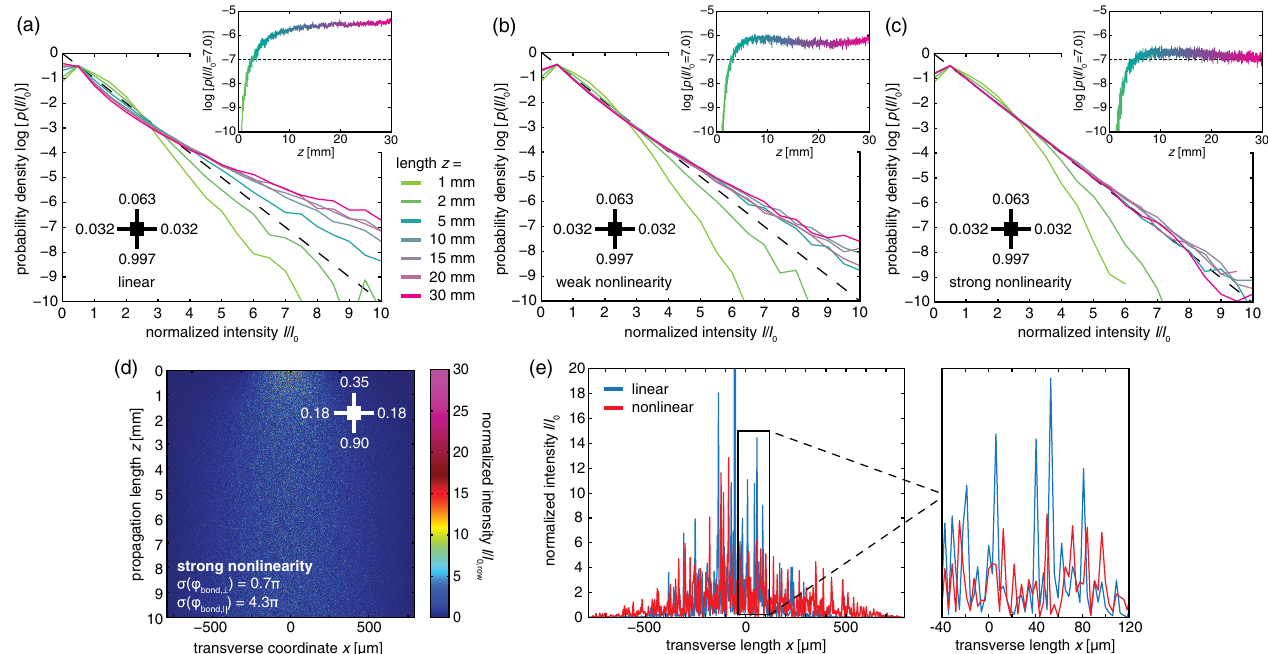
FIG. 12. Numerical results in the nonlinear regime. Histograms of the normalized intensity distribution resulting from a plane wave excitation for increasing nonlinearity and various propagation lengths. (a) Linear simulation taken from Fig. 2(b) for reference. (b) Numerical results invoking weak nonlinearity, that is, a relative nonlinear phase shift φ compared to the linear phase accumulation φ 0 along a given bond. Here, I is the local field intensity in the bond (the exciting field profile is normalized to I ¼ 1 ). While the probability density distribution still deviates from a speckle distribution at long propagation lengths, the difference is smaller. (c) Numerical results for strong nonlinearity ( φ probability density distribution is specklelike. There is no excess of extreme events other than expected from a random superposition of field components. (d) Introducing a Kerr-type nonlinearity to the situation depicted in Fig. 7(c) completely randomizes the phase distribution of the propagating field. This results in a thermal, i.e., speckle, distribution in accordance with Eq. (1). (e) Intensity profile along a horizontal line intersecting the extreme event highlighted in Fig. 7(c) at a propagation length z ≈ 3 mm in the linear regime (blue line) and the respective nonlinear case depicted in (d) (red line); compare with Fig. 10(e). In the linear case the central extreme event overshoots the mean intensity by 2 orders of magnitude (peak cut off in the figure). See the magnification on the